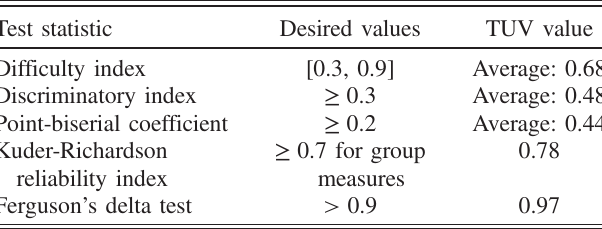
TABLE III. Summary of the results of the five statistical tests suggested by Ding et al. [2] for the